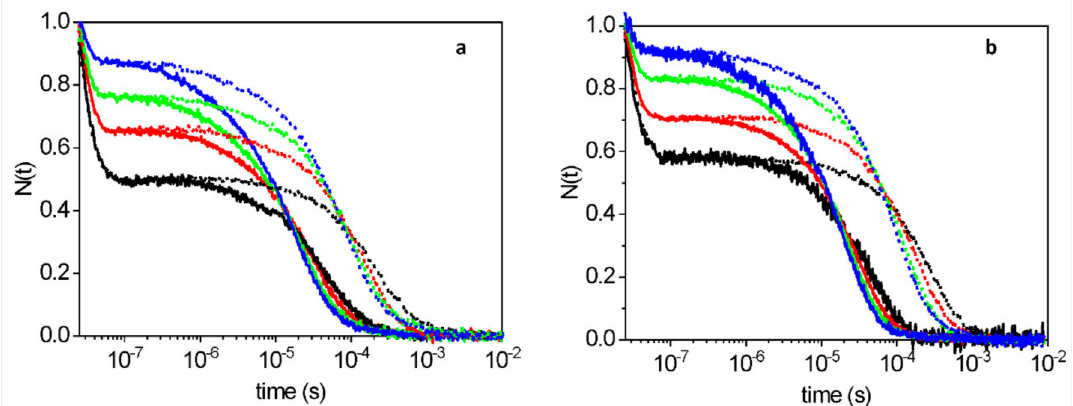
Figure 1. CO rebinding kinetics after nanosecond laser flash photolysis (LFP) of ( a ) WT1 and ( b ) WT4 solutions equilibrated with 1 atm CO (solid lines) and 0.2 atm CO (dotted lines) at 10 ◦ C (black), 20 ◦ C (red), 30 ◦ C (green) and 40 ◦ C (blue). Data are reported as the progress curve representing the fraction of deoxy molecules, N(t), as a function of time after photolysis. The absorbance change was monitored at 436 nm, following laser photolysis at 532